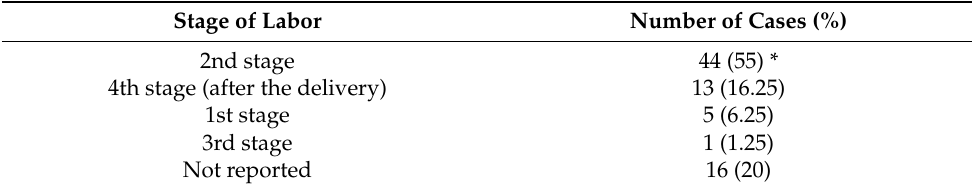
Table 2. Stage of labor related to pregnancy-associated SPM